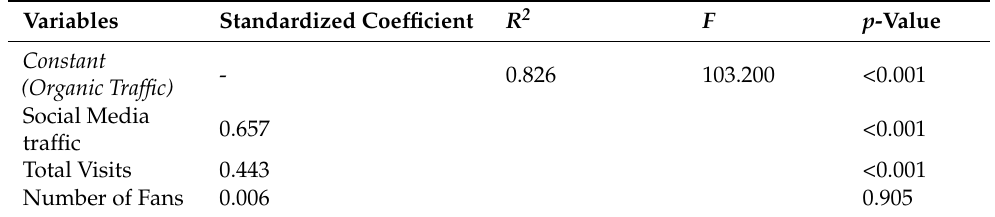
Table 9. Regression analysis for H4.